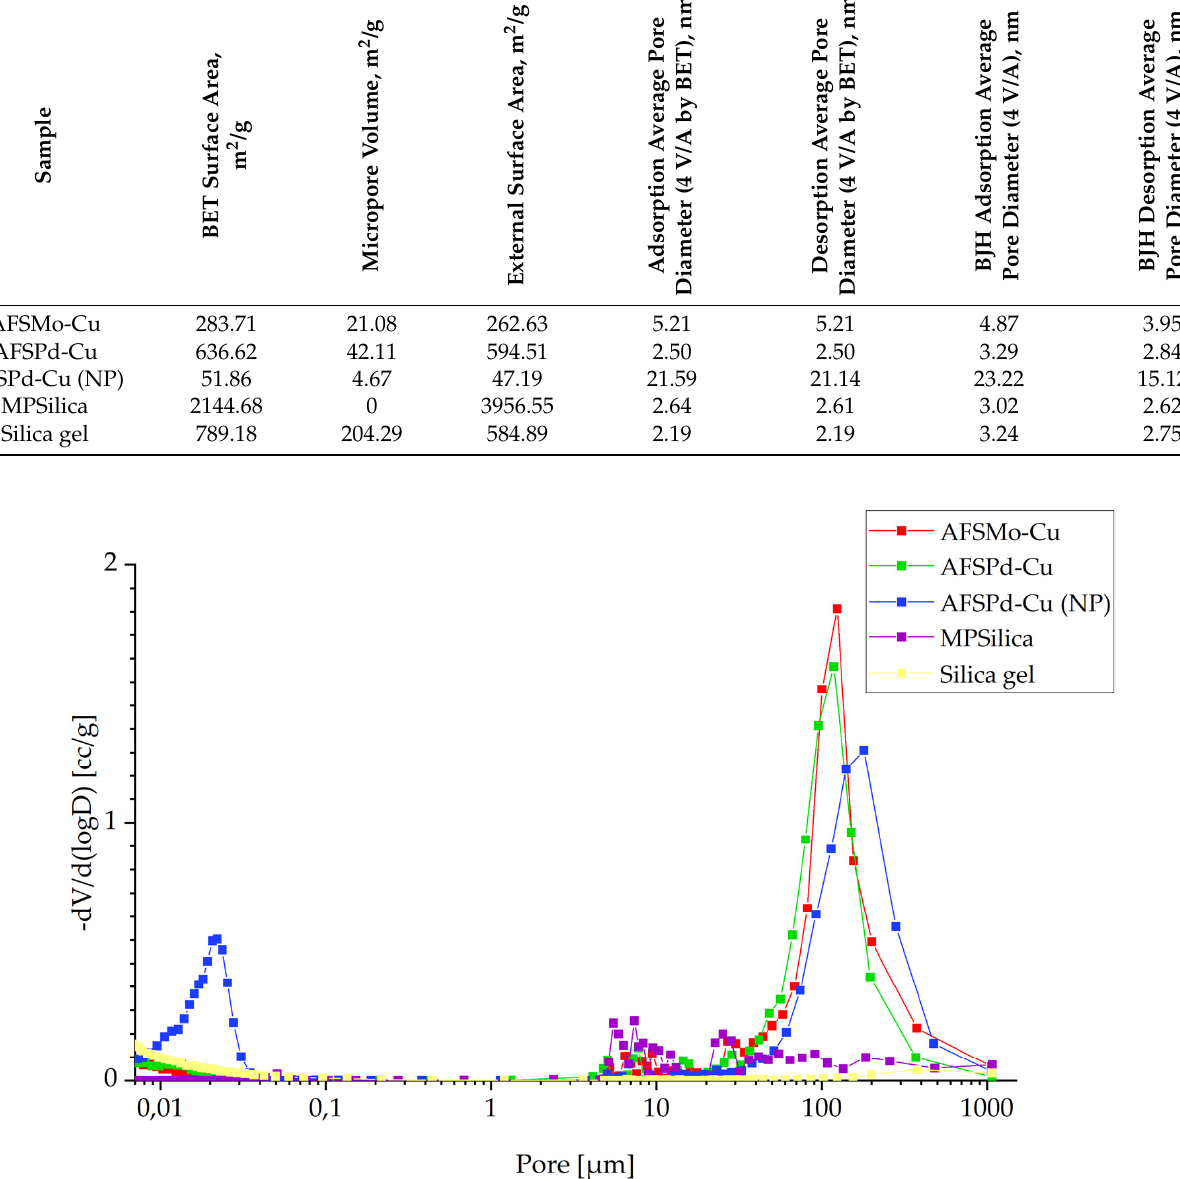
Figure 3. Pore distribution determined using mercury intrusion porosimetry. The distribution of the pores in Figure 3 shows that for MOS materials, the highest recorded initial increase related to the presence of macropores was observed. For the range of pore diameter between 100 and 200 µ m, the highest values of the total pore volume were observed, which will be influenced both by the fact that they are the pores with the largest volume, but in this case their number could also be significant. For MPSilica, the highest number of pores was in the size of 5 to 20 µ m. The cumulative pore volume in Figure 4 was associated with the pore distribution and sorbents characterised by a smaller pore size had a noticeably smaller pore